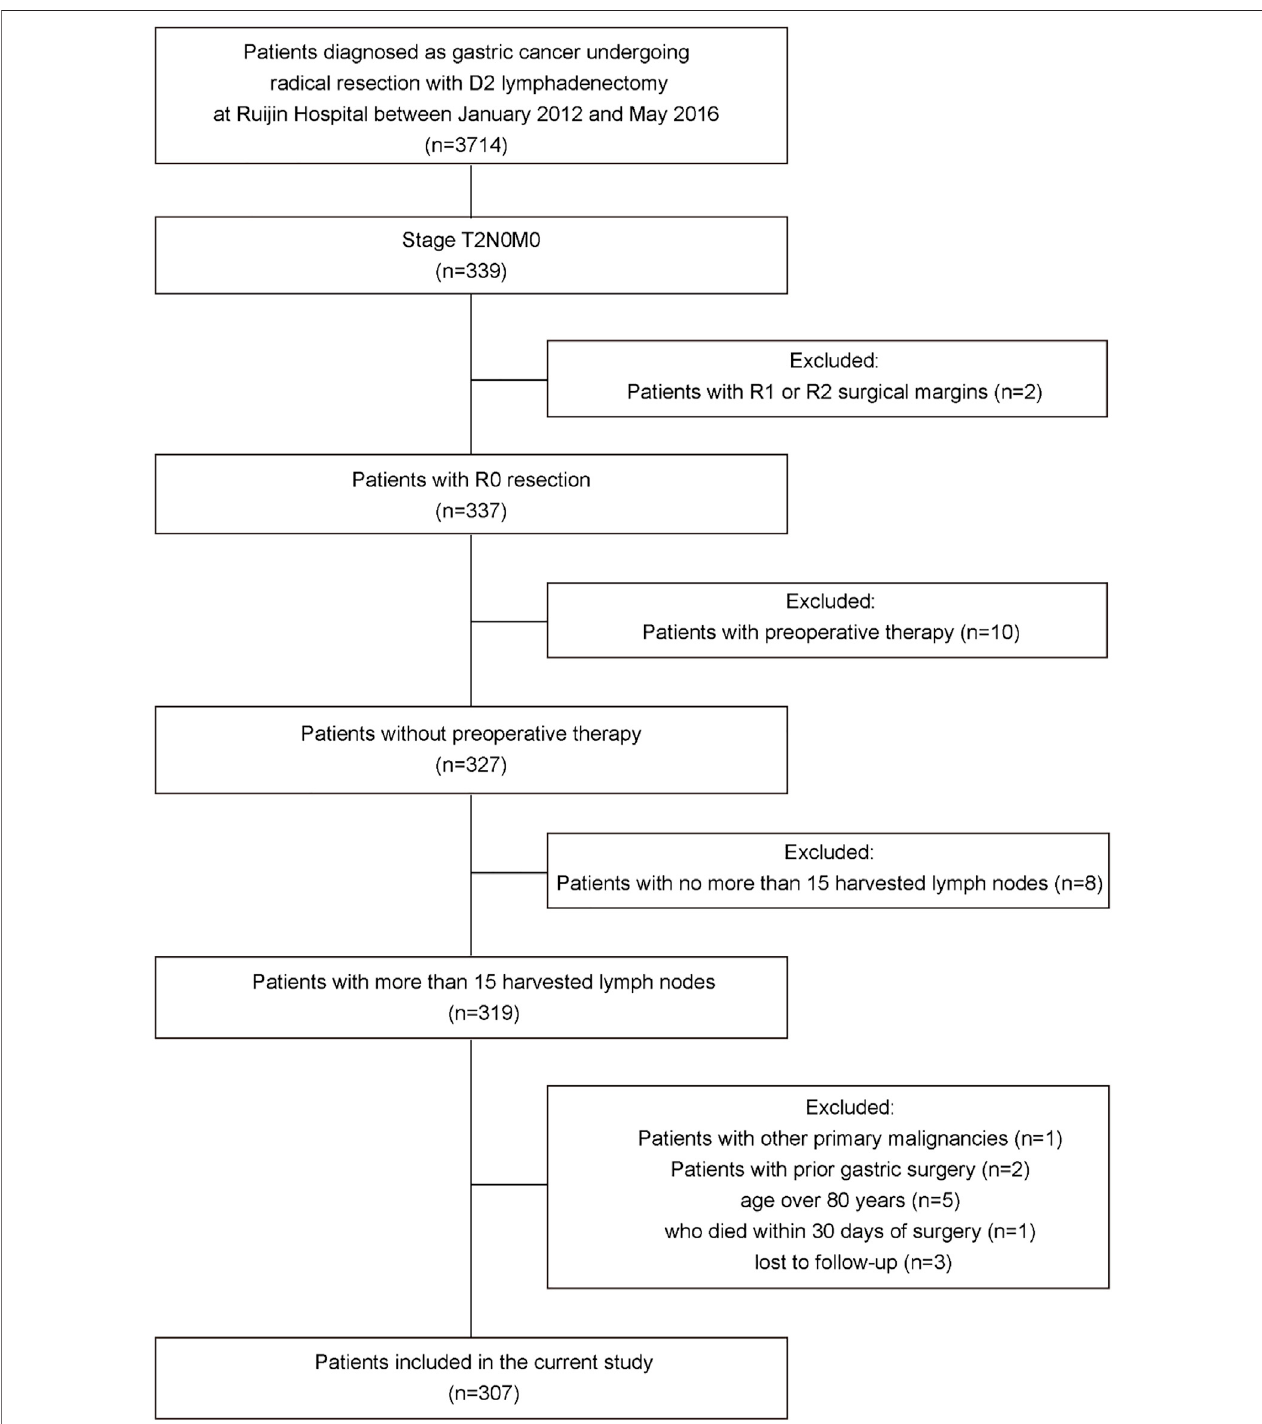
FIGURE 1 | Flowchart of patient selection